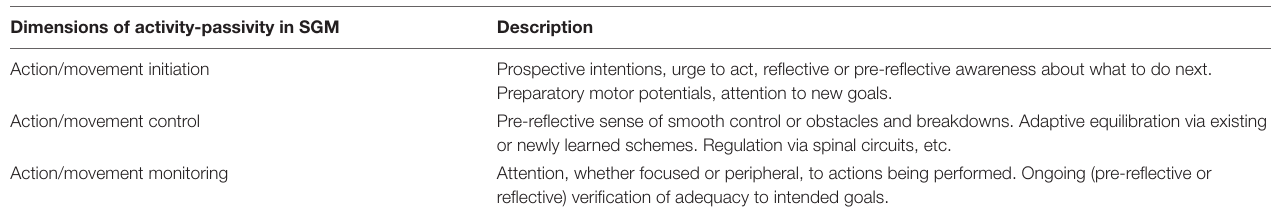
TABLE 2 | Dimensions of the active-passive distinction discussed in the text (there may be